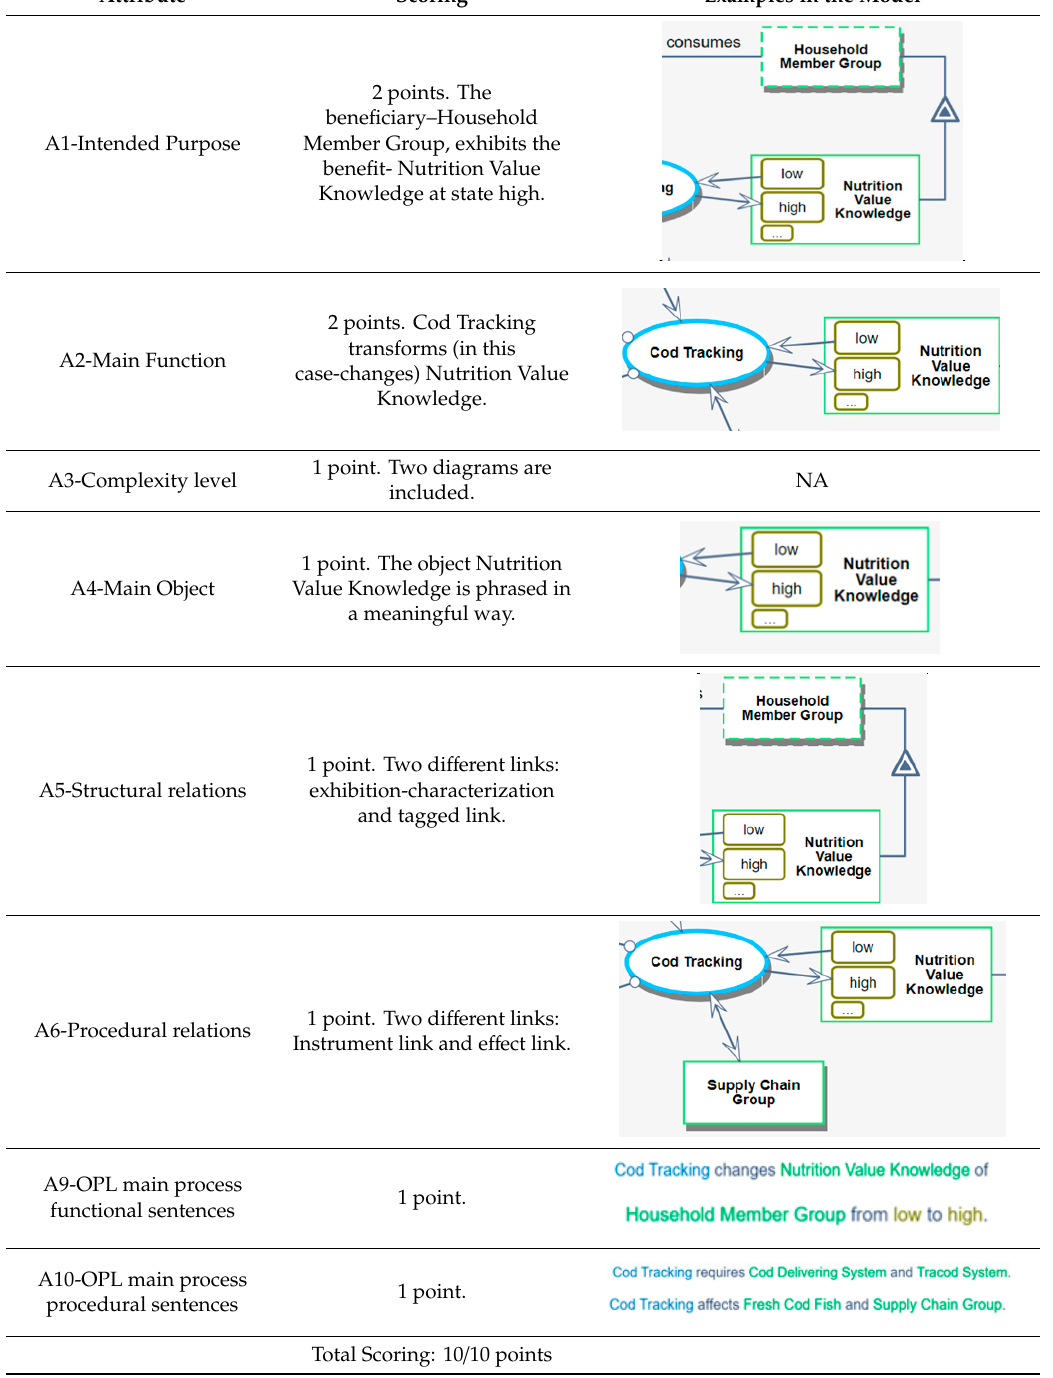
Table 6. STAR* analysis of codfish supply chain model—SD level. Attribute Scoring Examples in the Model